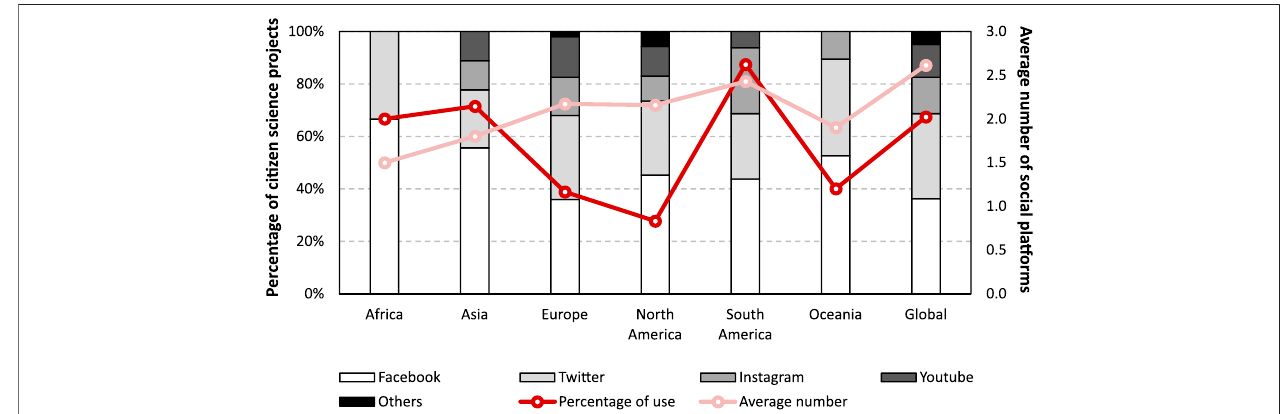
FIGURE 2 | Usage of social platforms by citizen science projects, per geographic location. Bars represent the relative importance of different social platforms in each continent. The dark-colored line represents the percentage of citizen science projects that used social platforms in each continent and the light-colored line the average number of social platforms where projects had an account in.